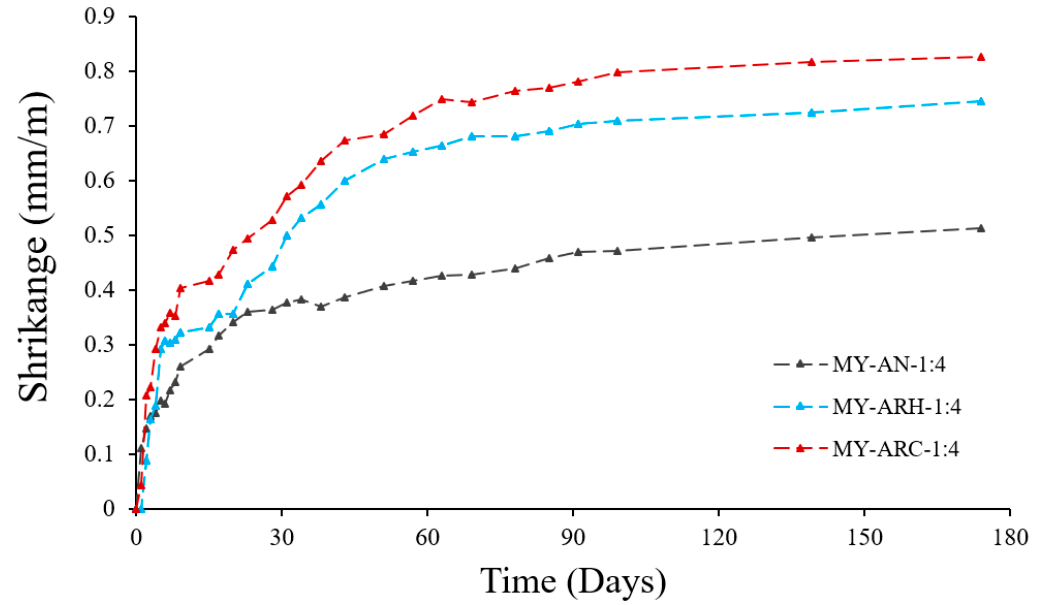
Figure 12. Evolution of shrinkage (mm/m) versus time (days). Cement mortars with a cement/aggregate ratio of 1:4.